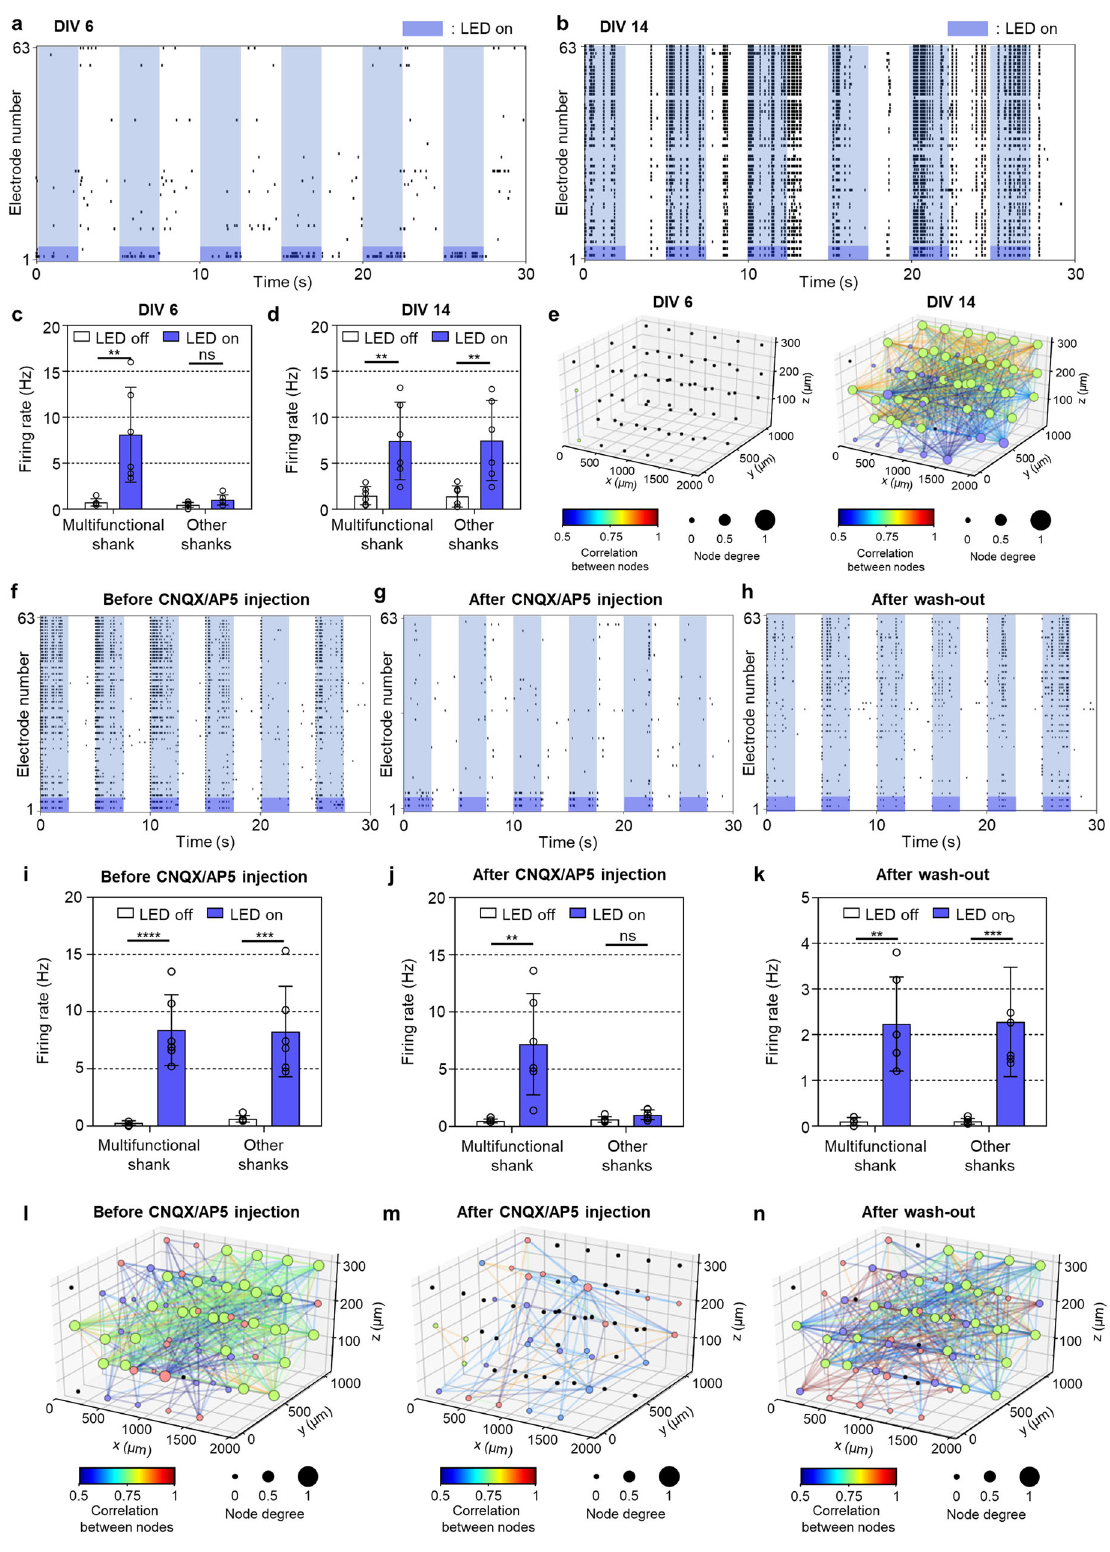
on some shanks (e.g., shank 15; S15) (Fig. 7d and 7e). This observation suggested that neurons at different positions along the z -axis could receive different synaptic inputs. To summar- ize, the distribution of synaptic latency in each region showed signal delays of approximately 3 to 8 ms between the two neural networks (Fig.